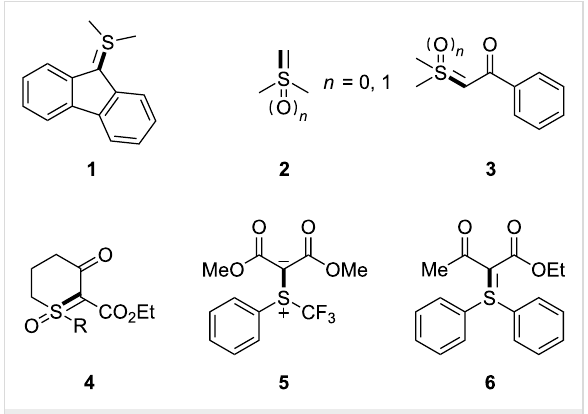
Figure 1: The selected examples of sulfur(IV) and sulfur(VI) ylides 1 [1], 2 [5-7], 3 [6,7,9], 4 [11,12], 5 [33,34], 6